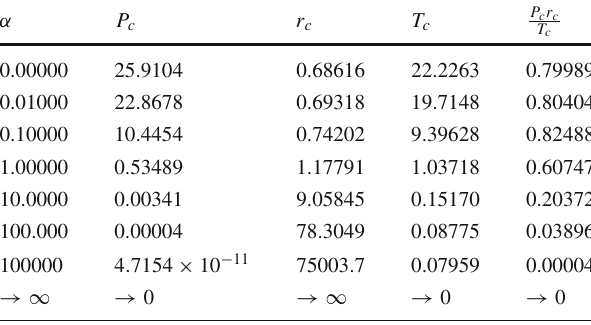
Table 6 Ricci flat black holes: k = 0, d = 7, q = 1 and c 0 = c 1